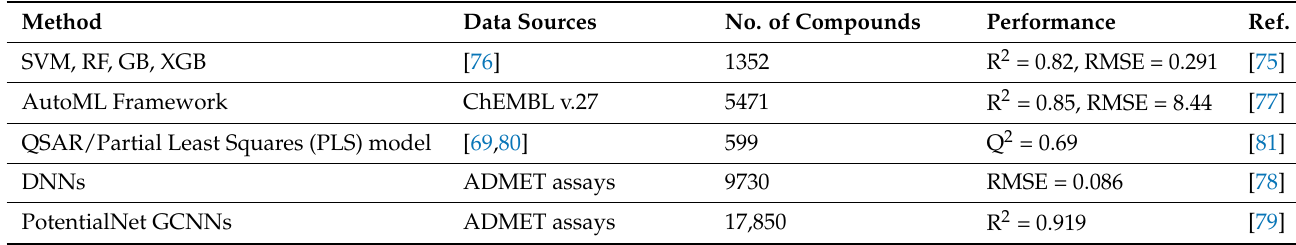
Table 3. Summary of recent AI-based studies predicting F u